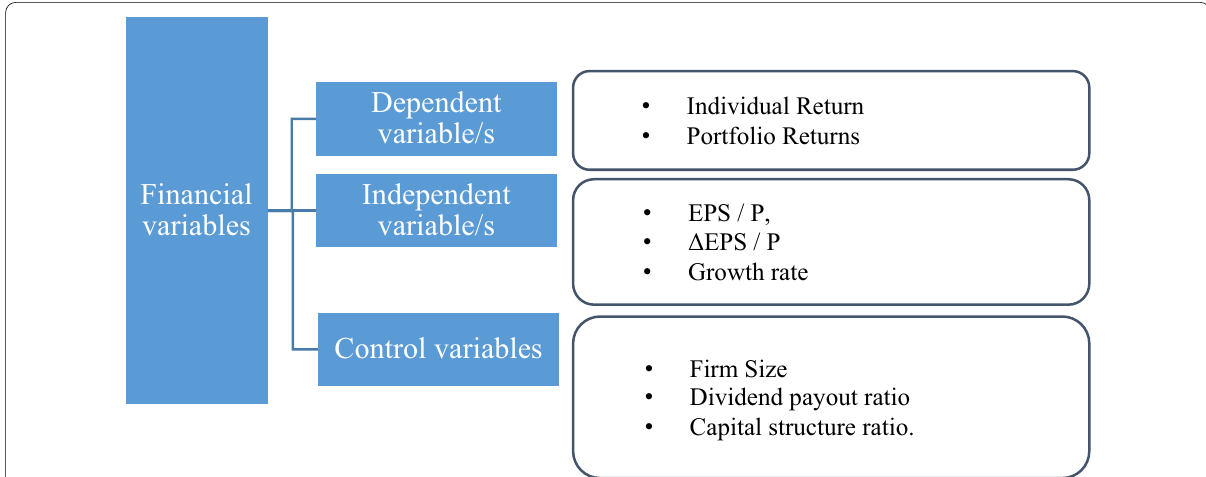
Fig. 19 Chart showing classification of finance variables in relation to the returns, firm earnings, firm size, and growth rate of firm, capital structure ratios